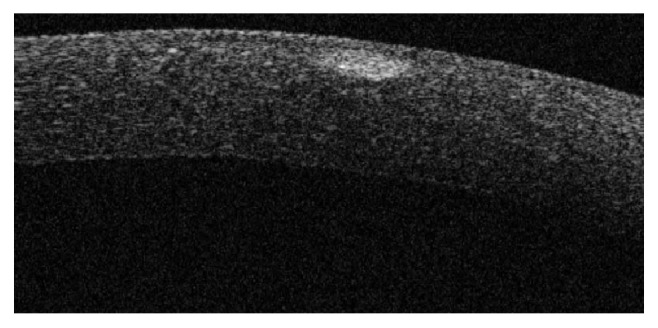
Corneal OCT reveals a hyper-reflective area immediately behind the epithelial layer in a 50-year-old patient one hour after undergoing optimal keratoplasty.